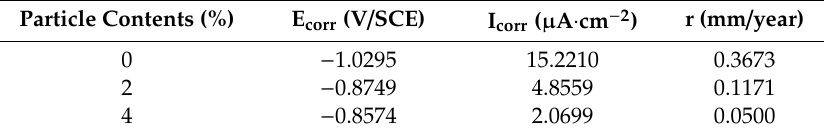
Table 1. Electrochemical parameters from polarization curves in Figure 9.